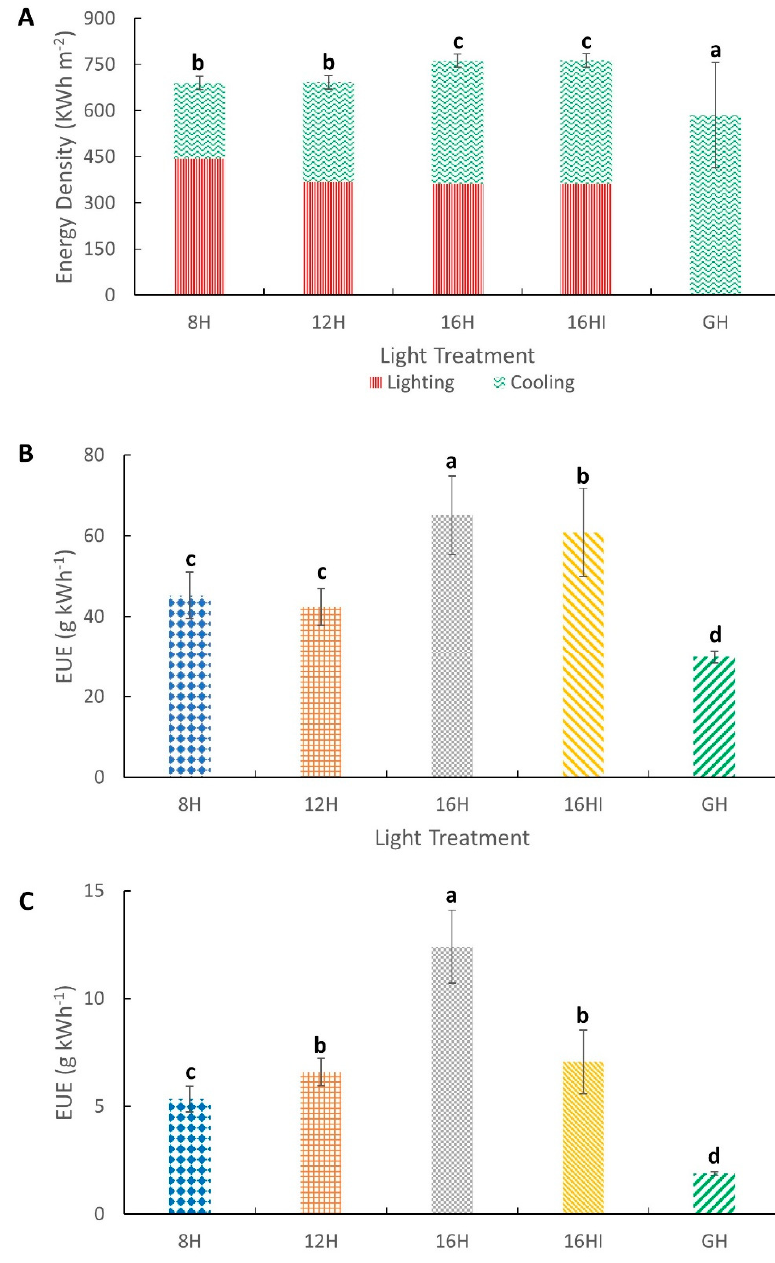
Figure 6. Electrical energy consumption and efficacies. ( A ) Total electrical energy consumption over a 175-day growth cycle (kWh m − 2 ). ( B ) Energy use efficacy (EUE) of biomass production (g kWh − 1 ). ( C ) Energy use efficacy of metabolite production (g kWh − 1 ). All values normalized to 1 m 2 of growth space. Values represents Mean (n = 72) ± Standard Deviation. Different letters above the error bars indicate statistical significance determined by Tukey’s HSD post hoc test at p < 0.05.